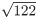
Barabási-Albert networks with p = 0.The network on the left was grown to order n = 122. It has 5 hubs of degrees {12, 17, 18, 19, 31} exceeding 122. The network on the right was grown to order n = 380. This network has 3 hubs of degrees {29, 47, 63} exceeding 380. The arrangement of nodes and bonds in these networks was created using the prefuse force directed lay-out in Cytoscape 3.4.0 [17].